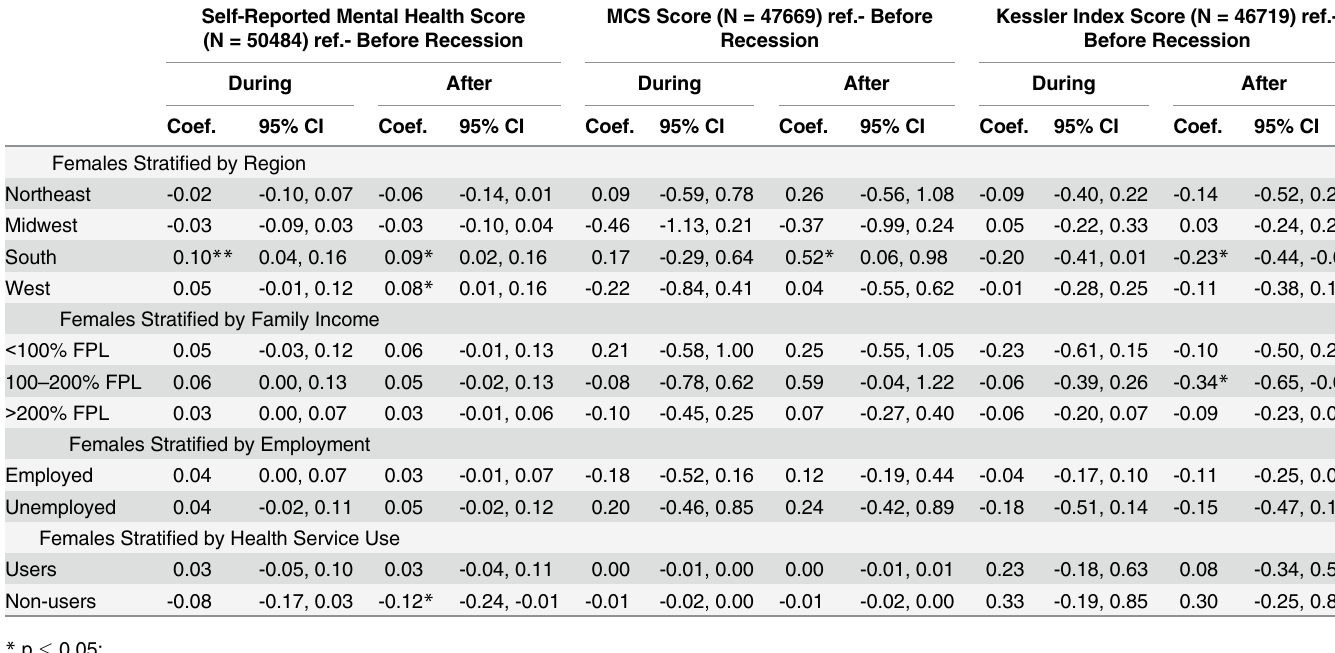
Table 4. Stratified multivariate analyses of recession indicators (during and after) and mental health indicators for females. Self-Reported Mental Health Score (N = 50484) ref.- Before Recession During After During After During After